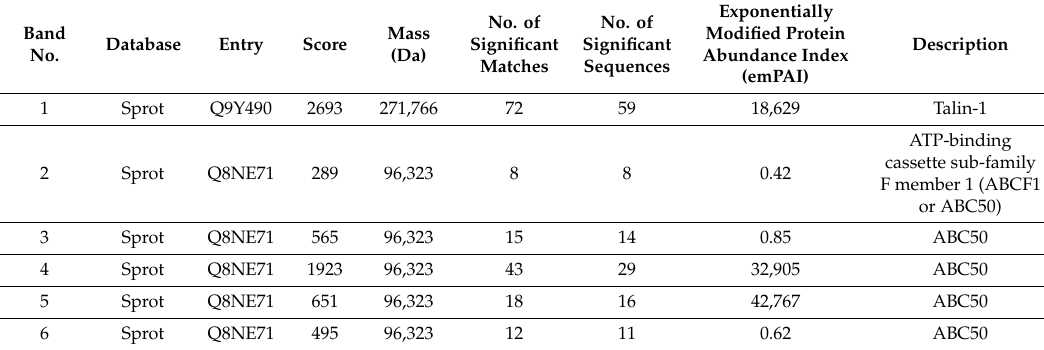
Table 3. Identification of cellular proteins pulled-down with 6b .